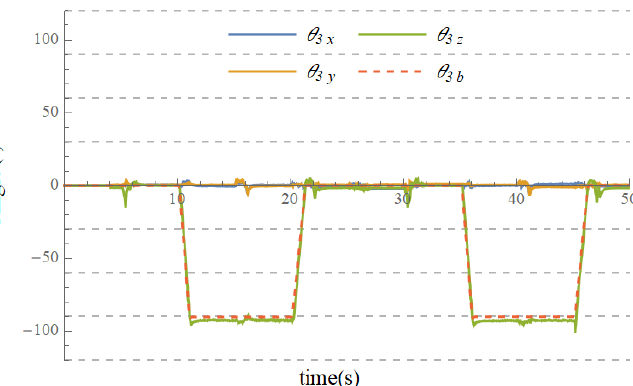
Figure 15. Evolution of Rotation Vector 3 when testing the link model using all